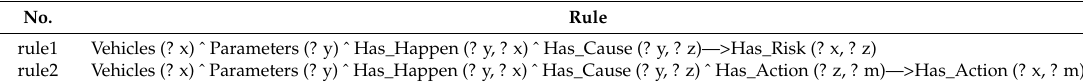
Table 2. Rollover reasoning